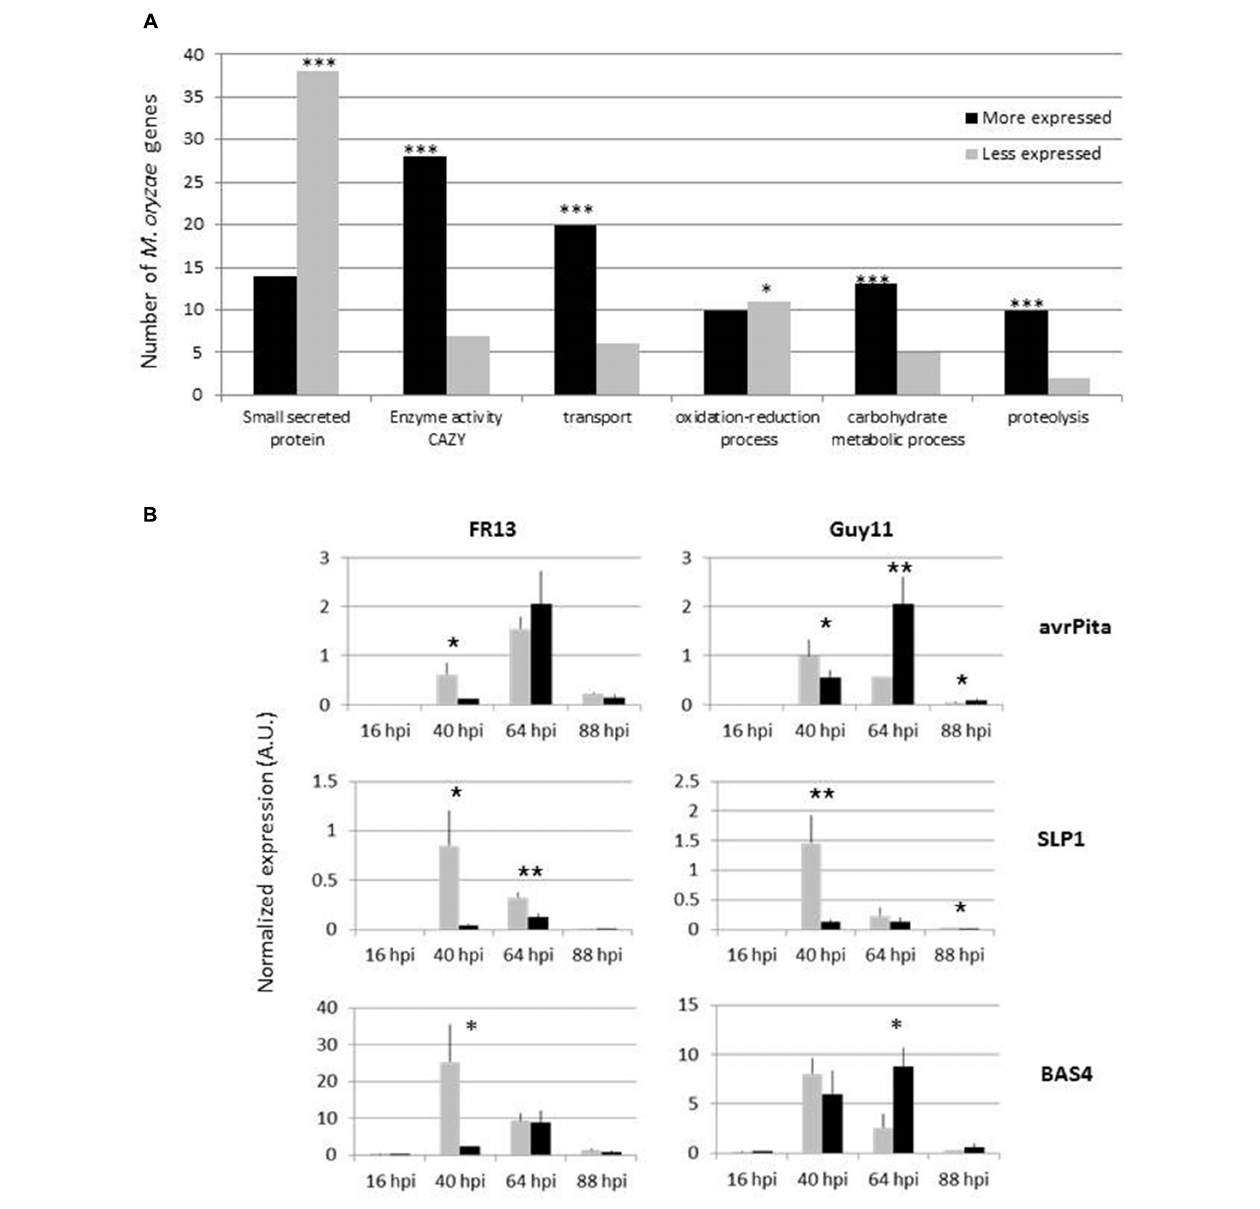
FIGURE 2 | Impact of drought on transcriptional regulation of pathogenicity processes. Nipponbare plants were drought-treated (3-day drought) or not and then infected with M. oryzae FR13 isolate according to the protocol described in Figure 1 . RNAseq analysis at 4 dpi was used to measure fungal gene expression in planta . (A) The fungal genes differentially expressed (more or less after droughted compared to unstressed plants) were categorized (see Materials and Methods) and the frequency of each category was compared to the frequency expected from the fungal genome. Only the categories with more than 10 genes are shown. A χ 2 test (corrected by Benjamini) was used to evaluate significant differences between dataset and genome ( ∗ P < 0.05; ∗∗∗ P < 0.001). (B) Gene expression of three fungal effectors was measured by RT-qPCR during all fungal cycle in plants that experienced no stress (gray) or 3-day drought (black bars). Two different virulent isolates of M. oryzae were used (Guy11 and FR13). The expression was normalized with the constitutive fungal gene MG4. The data represent the mean and SD from four replicates. A t -test was used to compare gene expression in non-stressed and drought stressed plants ( ∗∗ P < 0.01; ∗ P <